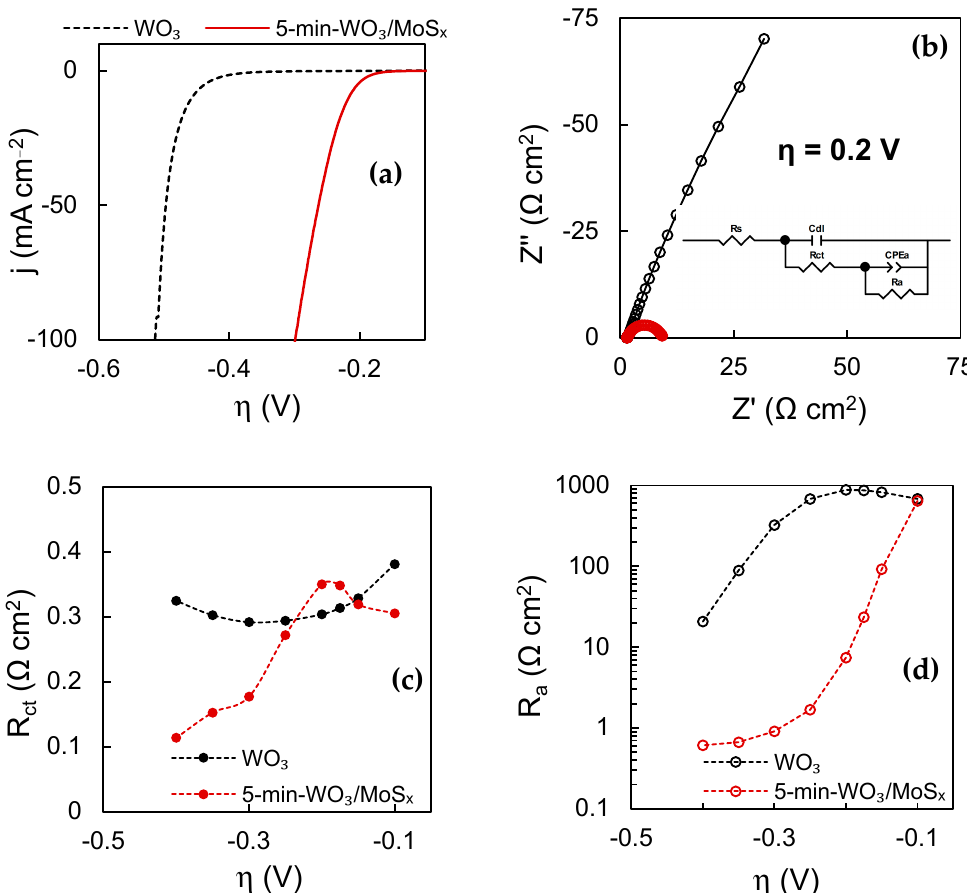
Figure 12. HER characterization data of WO 3 and heterostructured films: LSV scans at 2 mV s − 1 corrected by iR-drop ( a ); EIS spectra obtained at overpotential − 0.2 V in complex plane coordinates, where solid lines show equivalent circuit fits (inset shows equivalent circuit used to fit spectra) ( b ); values of R ct as a function of overpotential ( c ); values of R a as a function of overpotential ( d ).